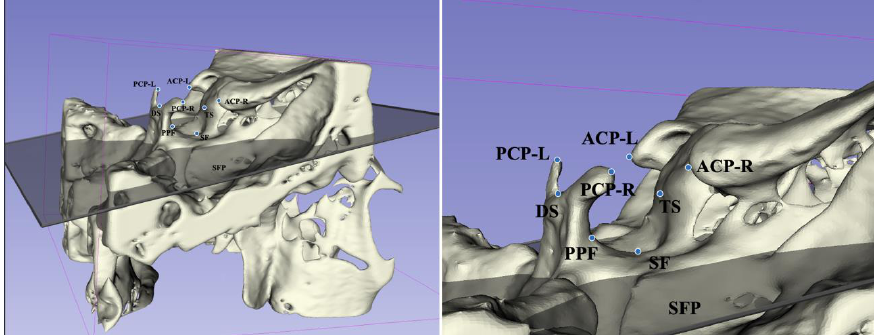
Figure 1. Sella turcica landmarks based on CBCT. ACP-R: the apex of the anterior clinoid process on the right side; ACP-L: the apex of the anterior clinoid process on the left side; PCP-R: the apex of the posterior clinoid process on the right side; PCP-L: the apex of the posterior clinoid process on the left side; DS: the dorsum sellae point; TS: tuberculum sellae; PPF: the most posterior point of the posterior wall of the sella turcica; SF: the deepest point of the sella turcica; SFP: sella floor plane.